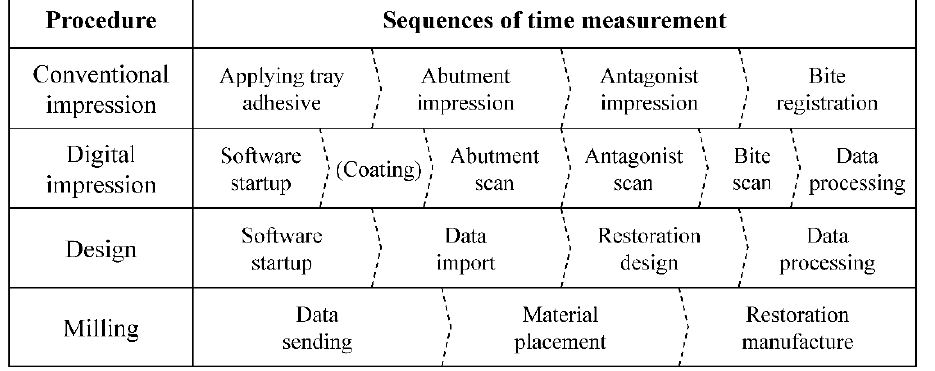
Figure 3. Specific steps in the procedure for time measurement.